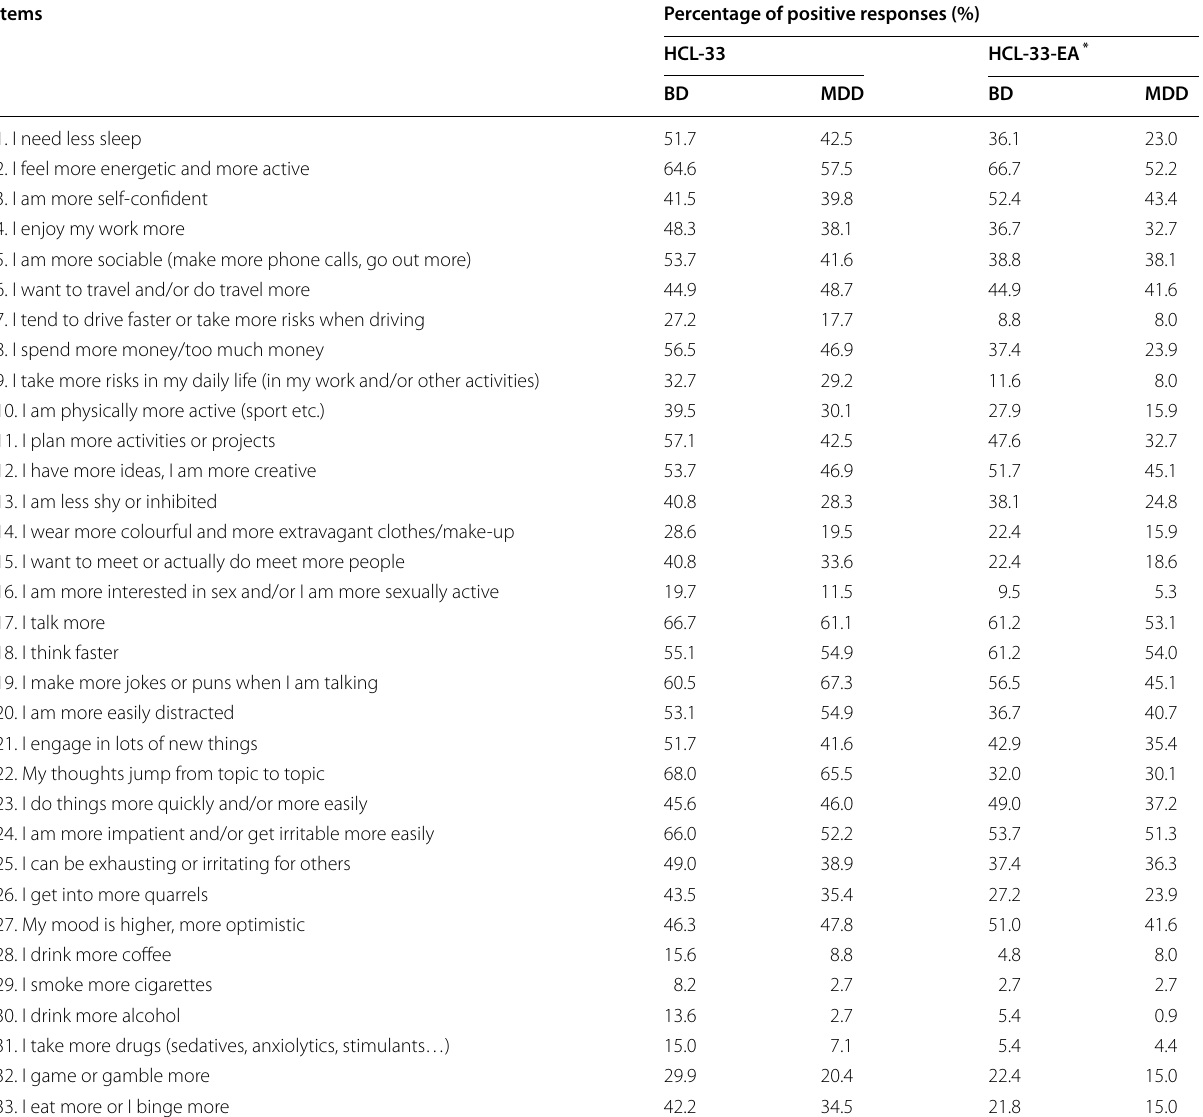
Table 3 Percentage of positive responses by adolescents with Major Depressive Disorder and Bipolar Disorder on the HCL‑33 and HCL‑33‑EA